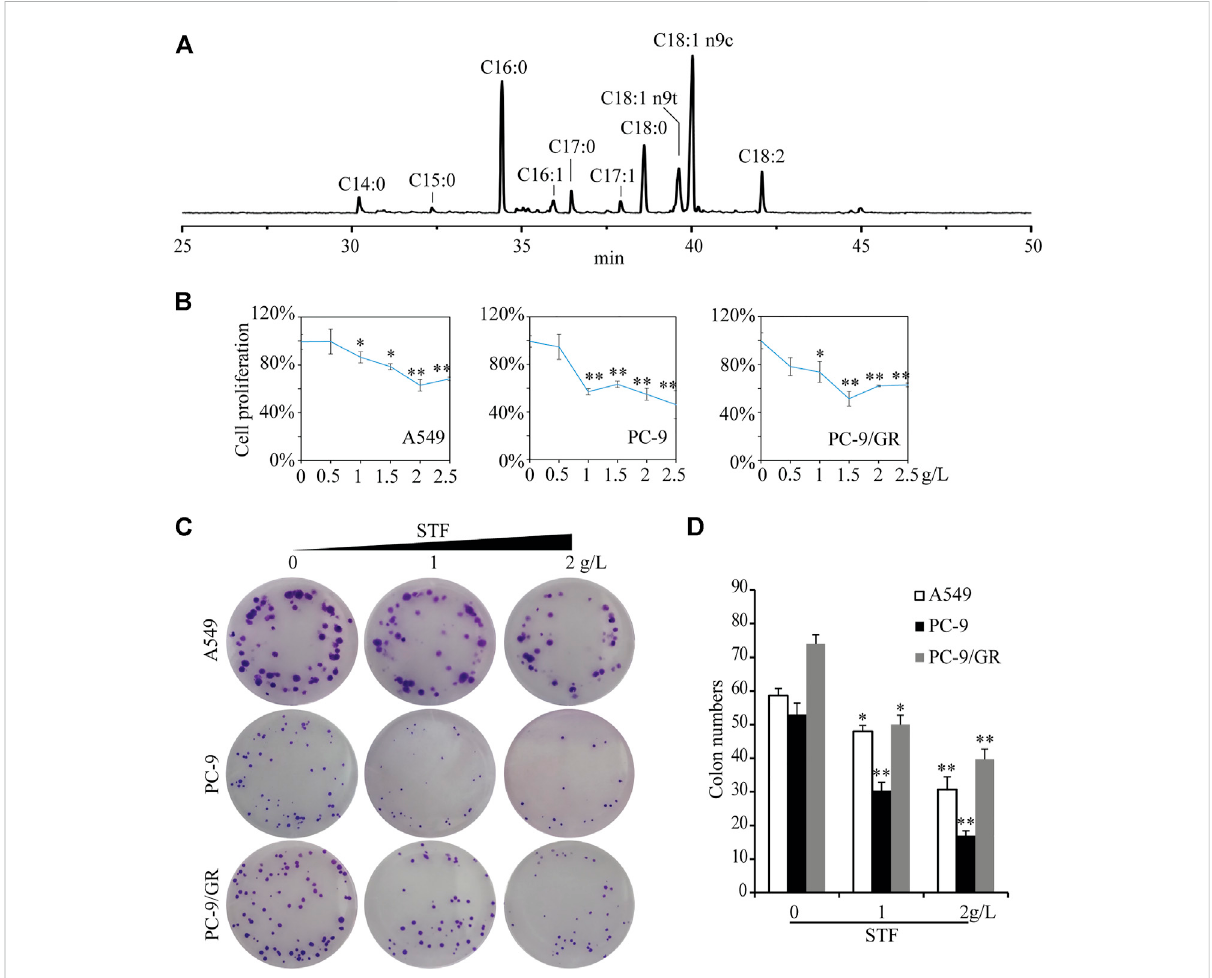
FIGURE 1 Inhibition of non-small-cell lung cancer (NSCLC) cell proliferation and colony formation by sheep tail fat (STF). (A) The fatty acid pro fi le of STF was estimated by GC-MS analysis. (B) A549, PC-9, and PC-9/GR cells were plated overnight in 96-well plates. The cells were switched to a serum- free medium for 12 h, followed by treatment with different concentrations of STF for 48 h. The cell proliferation was determined using the 3-(4,5- dimethylthiahiazo-2-yl)-3,5-diphenyltetrazolium bromide (MTT) assay. (C) Three NSCLC cell lines were subjected to STF treatment for 2 weeks, and the formed colonies were imaged. (D) The number of colonies in each group was then counted. * p < 0.05, ** p <